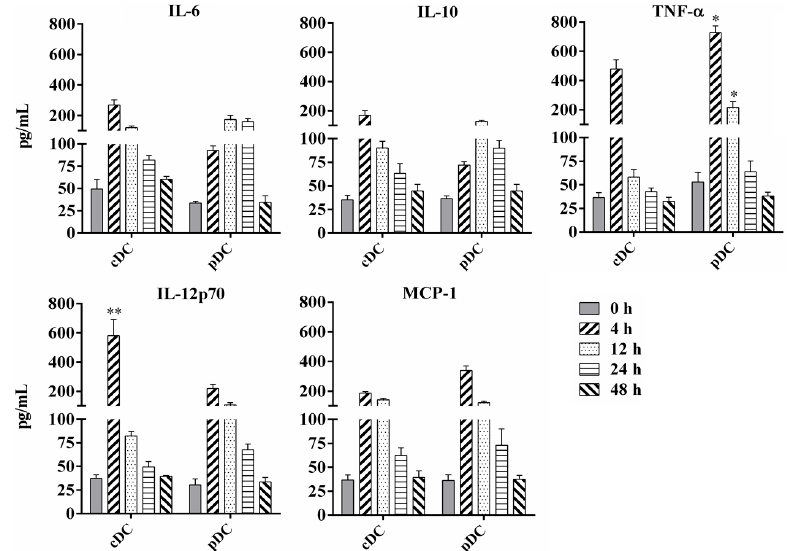
Figure 4. Analysis of cytokine production by murine splenic cDC and pDC following BCG infection. Splenic cDCs and pDCs were collected from naive mice or 10 8 BCG injected mice at different time points and cultured at 37 °C with 5% CO 2 for 24 h. Cytokine concentrations of TNF- α , IL-6, IL-10, IL-12p70, and MCP-1 in the cell culture supernatant were analyzed using FACS Calibur after staining with Cytometric Bead Array (CBA) Mouse Inflammation Kit. The experiment was repeated three times, and data are shown with the mean value of the three independent experiments. The bar graphs show the mean ± SD. * P < 0.05; ** P < 0.01.